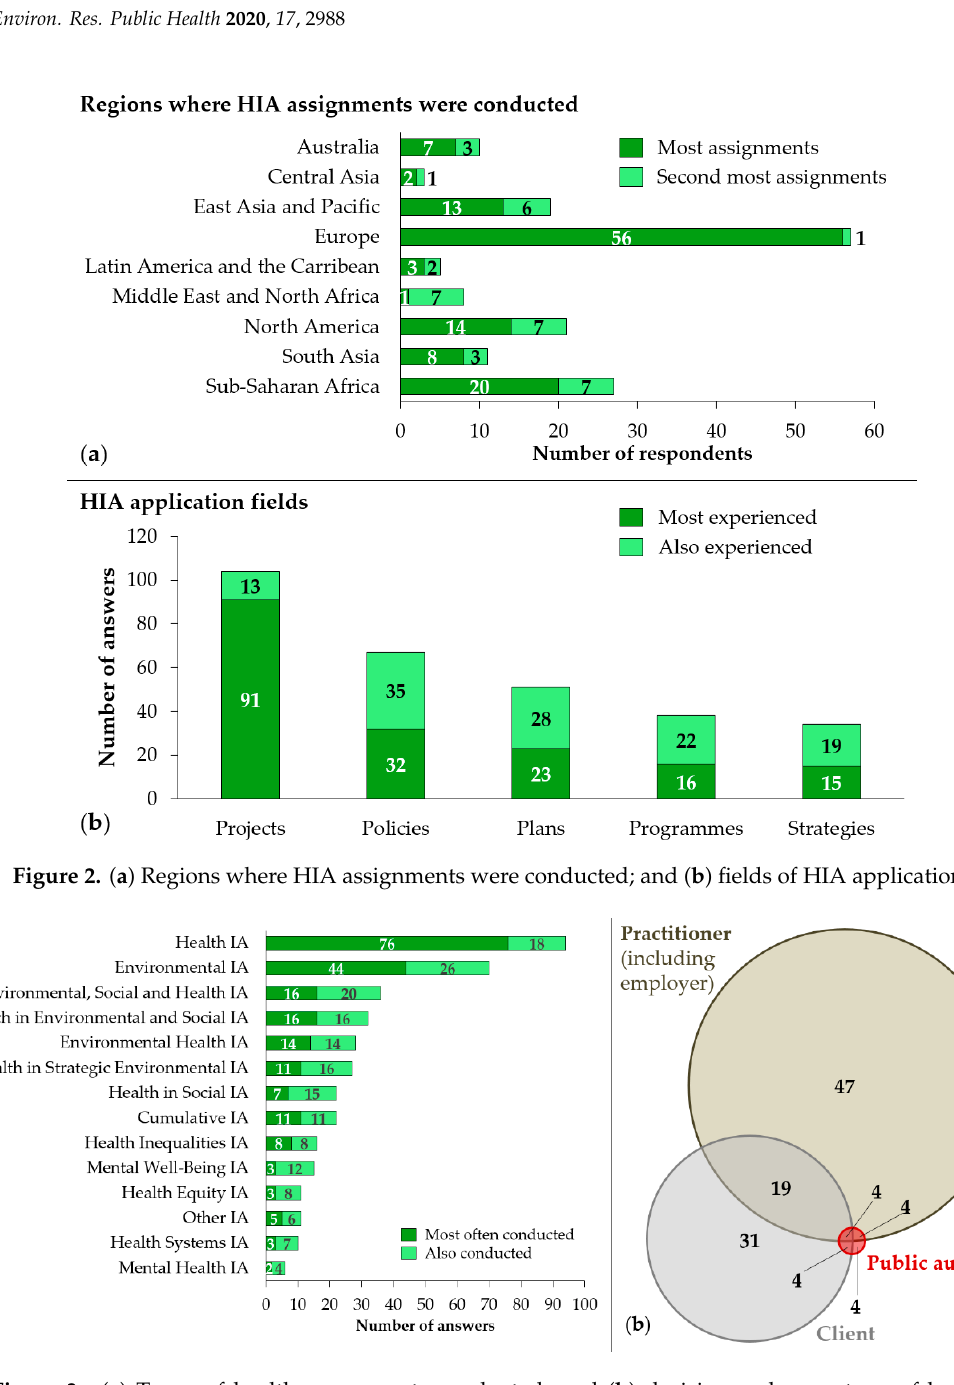
Figure 3. ( a ) Types of health assessments conducted; and ( b ) decision-maker on type of health assessment to conduct.